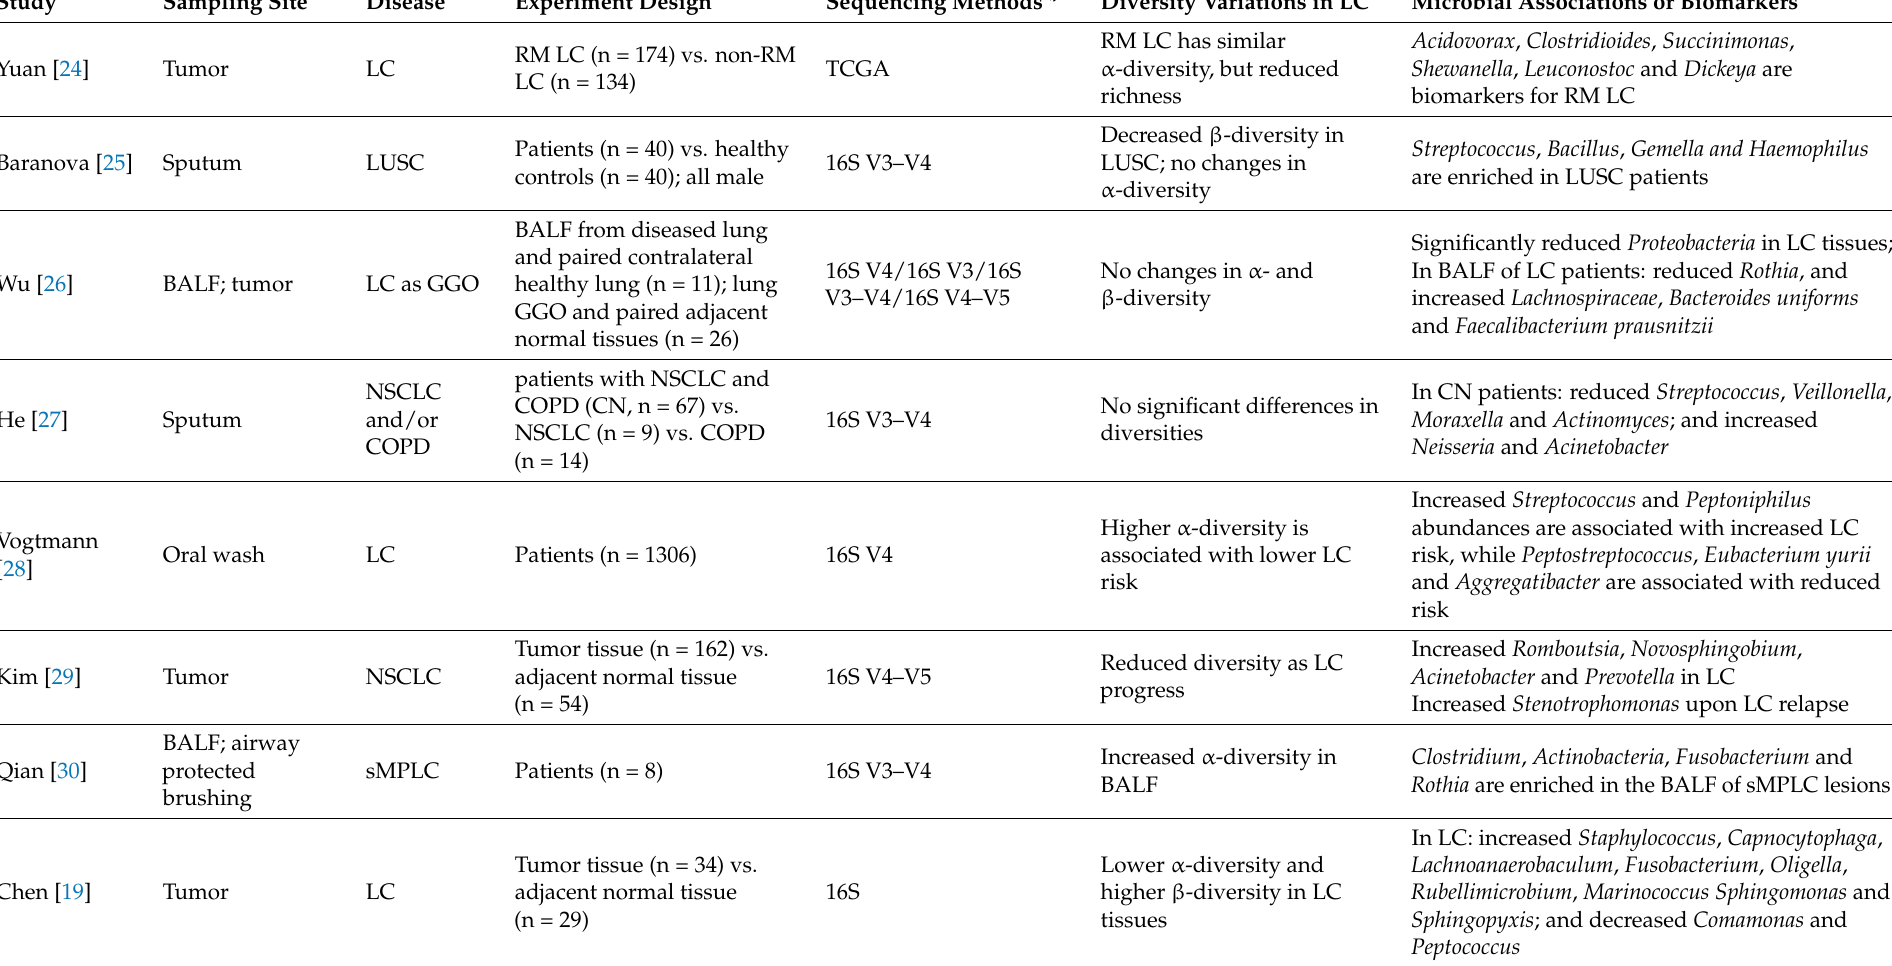
Table 1. Summary of studies of lung cancer-associated microbiome in the oral cavity and respiratory tract (most recent